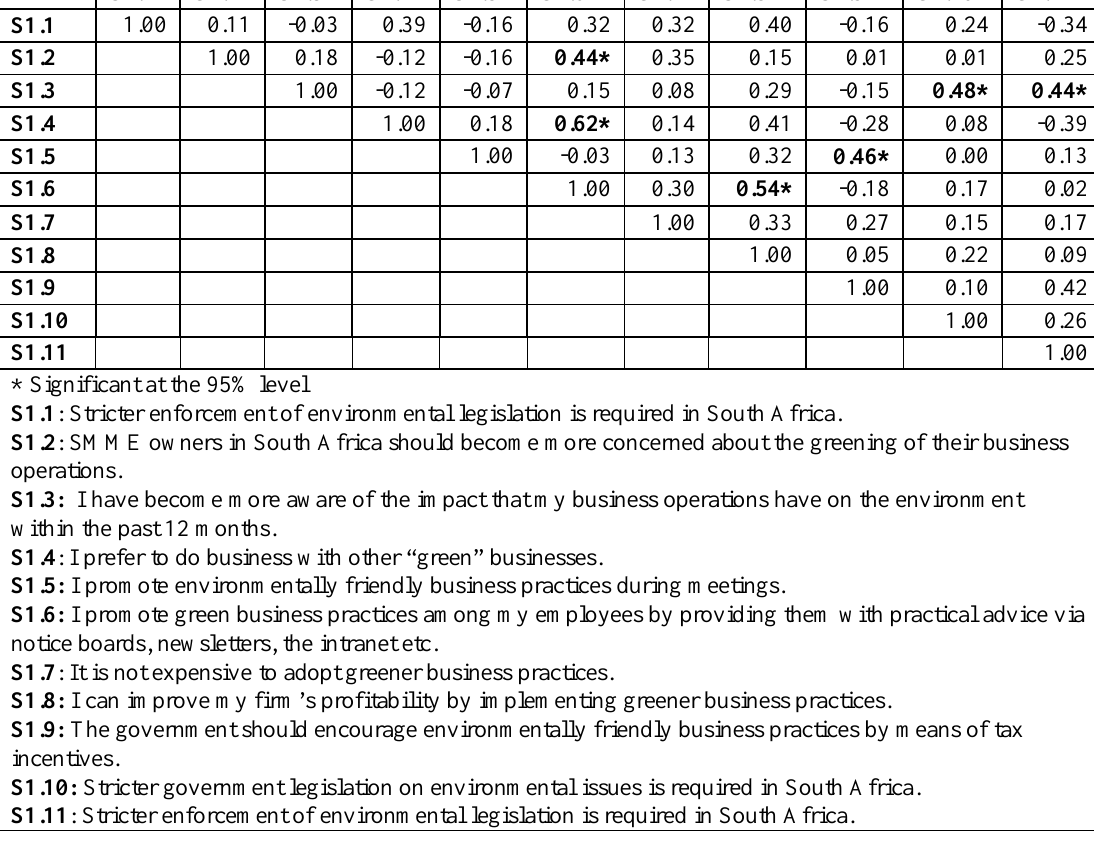
Table 3: Pearson correlations